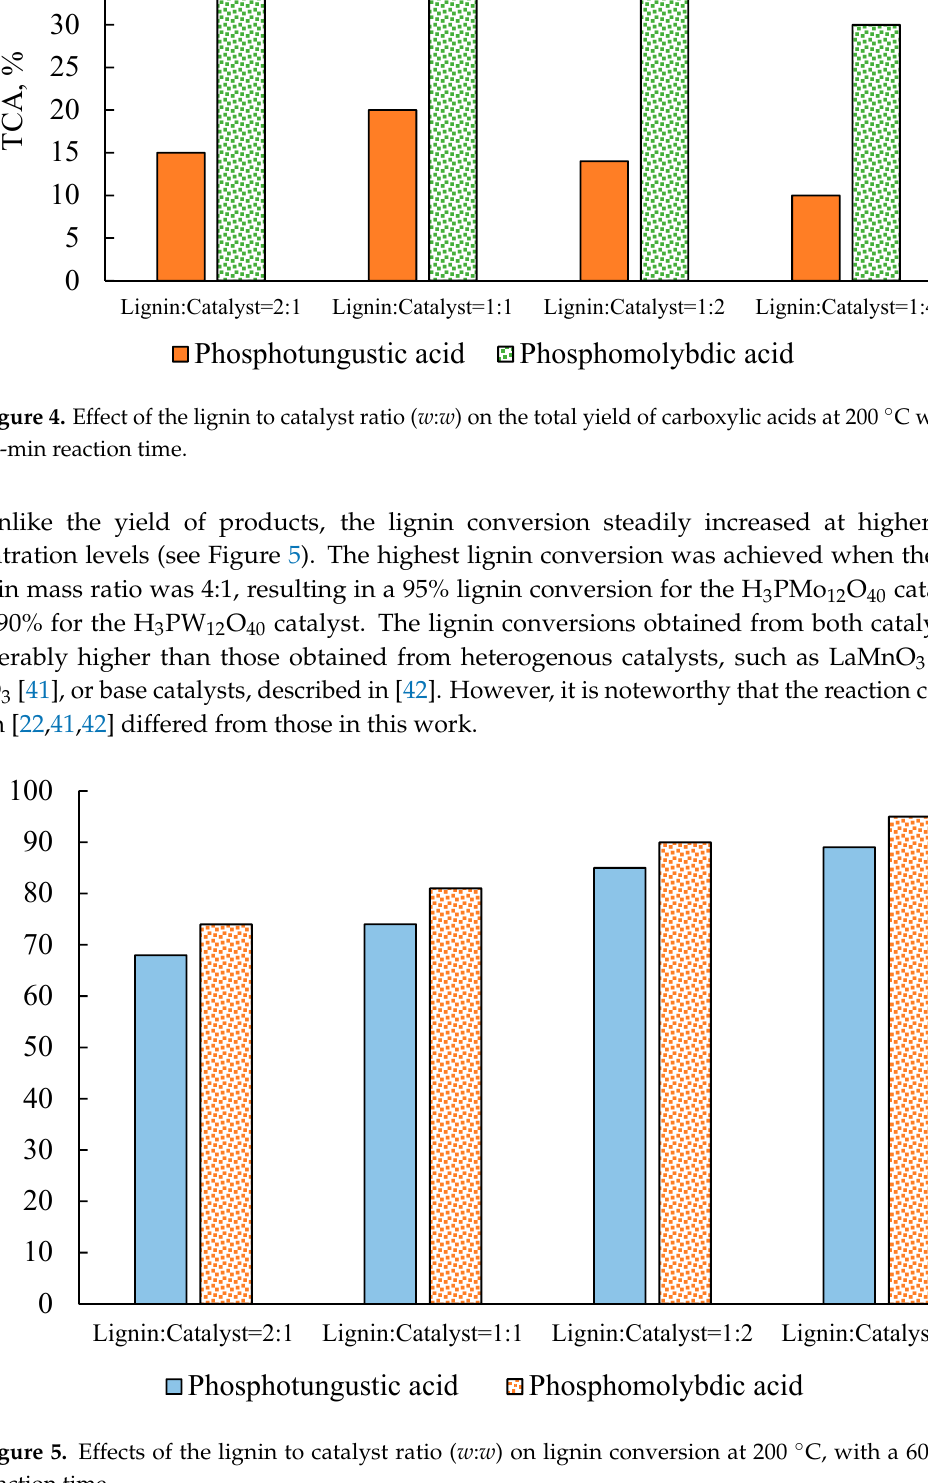
Figure 5. Effects of the lignin to catalyst ratio ( w : w ) on lignin conversion at 200 °C, with a 60-min reaction time.